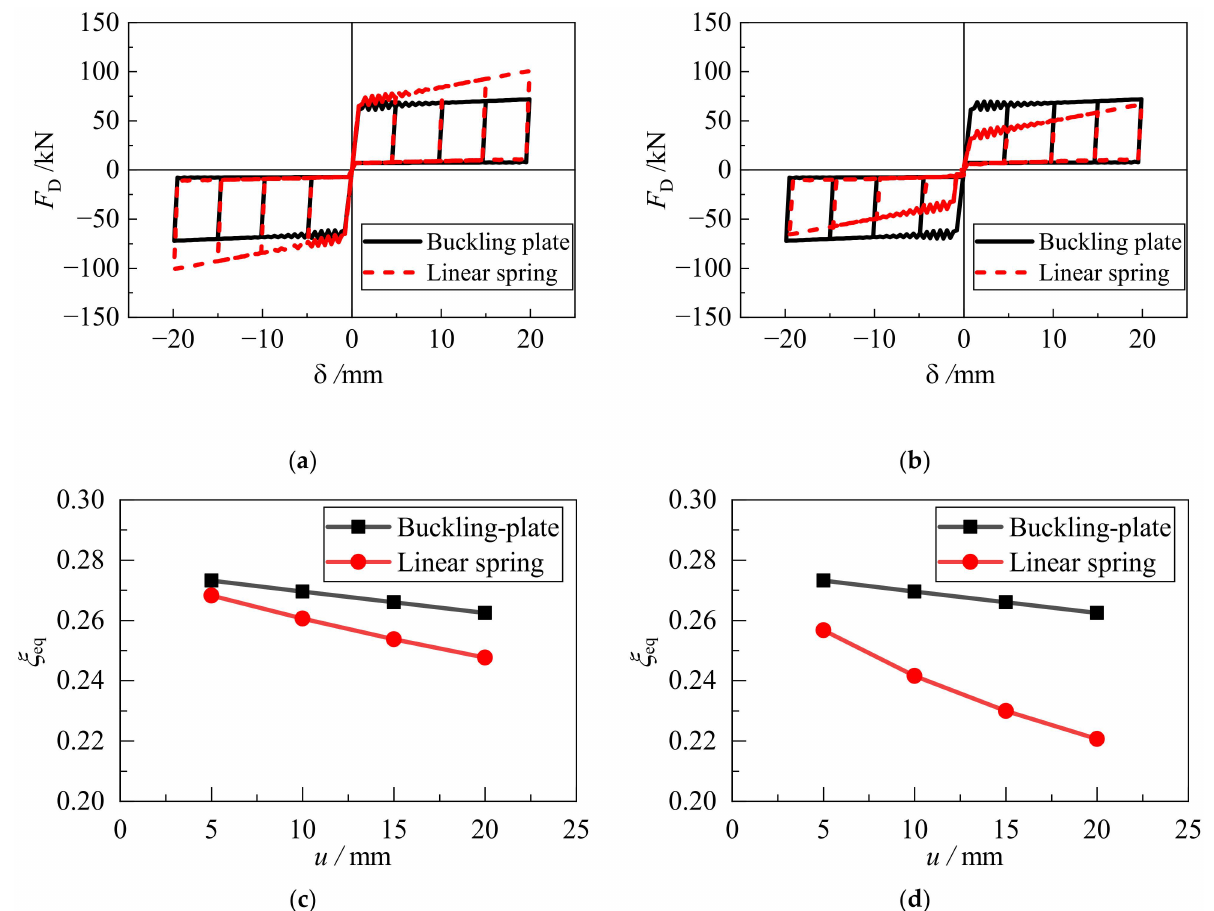
Figure 8. Comparison between BPSCFD and VFLSCD: ( a ) force-displacement curves for case 1;